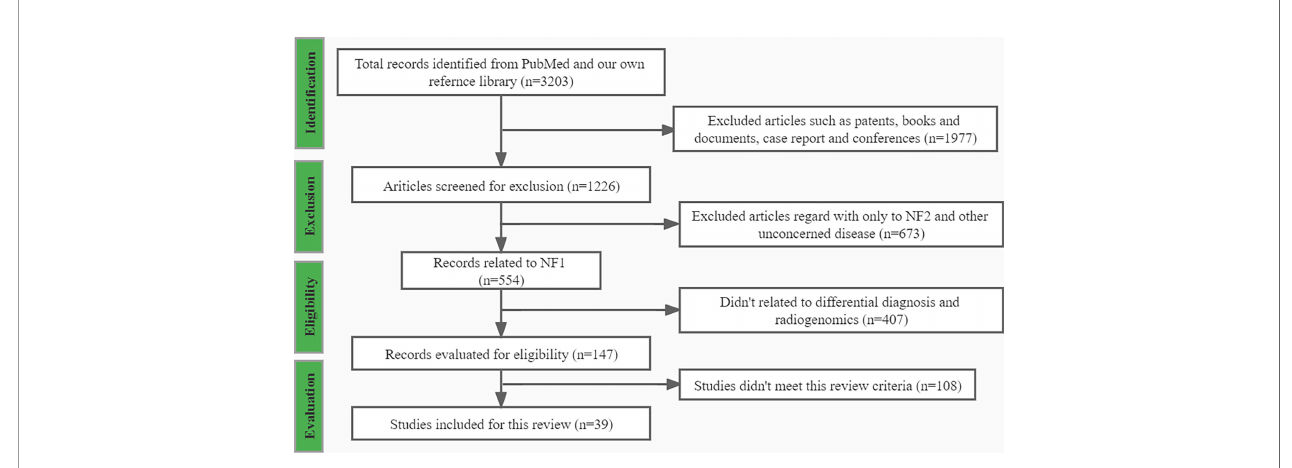
FIGURE 1 | The fl owchart of publications screening